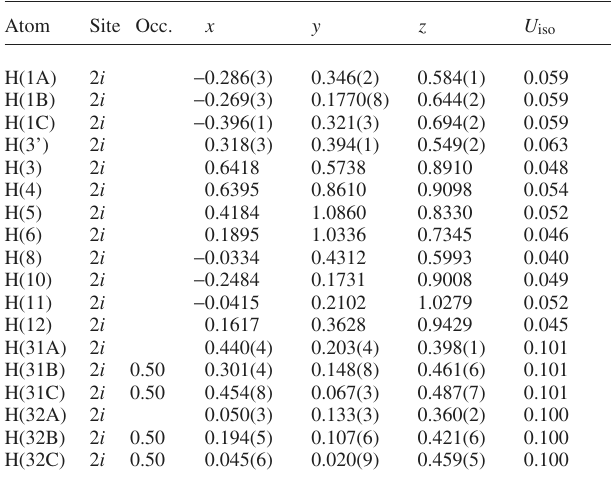
Table 2. Atomic coordinates and displacement parameters (in Å 2 ) .